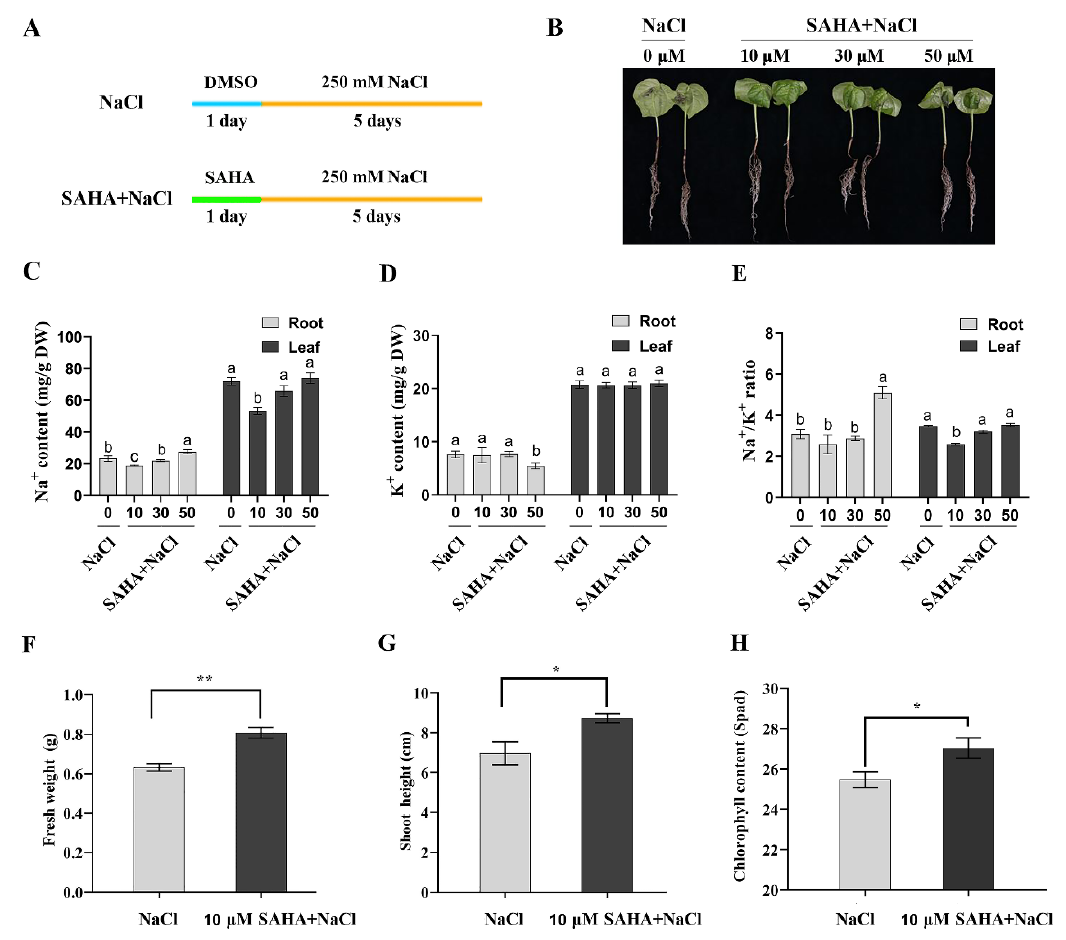
Figure 2. E ff ects of exogenous application suberoylanilide hydroxamic acid (SAHA) on phenotype and physiology in cotton under 250 mM NaCl stress. ( A ) Experimental scheme of SAHA pretreatment and control groups. The three-week-old cotton seedlings were pretreated with SAHA or DMSO (control) for 24 h, and then subjected to 250 mM NaCl for 5 days. ( B ) Morphological changes of cotton seedlings treated with di ff erent concentrations of SAHA (0 / 10 / 30 / 50 µ M) and 250 mM NaCl. ( C – E ) The e ff ects of di ff erent concentrations of SAHA pretreatment on Na + ( C ), K + ( D ) content, and Na + / K + ratio ( E ) in roots and leaves after 250 mM NaCl stress for 5 days. Values are shown as means ± SD of three biological replicates. Di ff erent lowercase letters indicate significant di ff erence ( p < 0.05) between di ff erent groups. Tukey’s test after one-way ANOVA was used. ( F – H ) Fresh weight ( F ), shoot weight ( G ), and relative chlorophyll content (Spad) ( H ) of cotton seedlings pretreated with or without 10 µ M SAHA under 250 mM NaCl stress for 5 days. Values are shown as means ± SD of three biological replicates. Student’s t -test, * p < 0.05, ** p < 0.01.